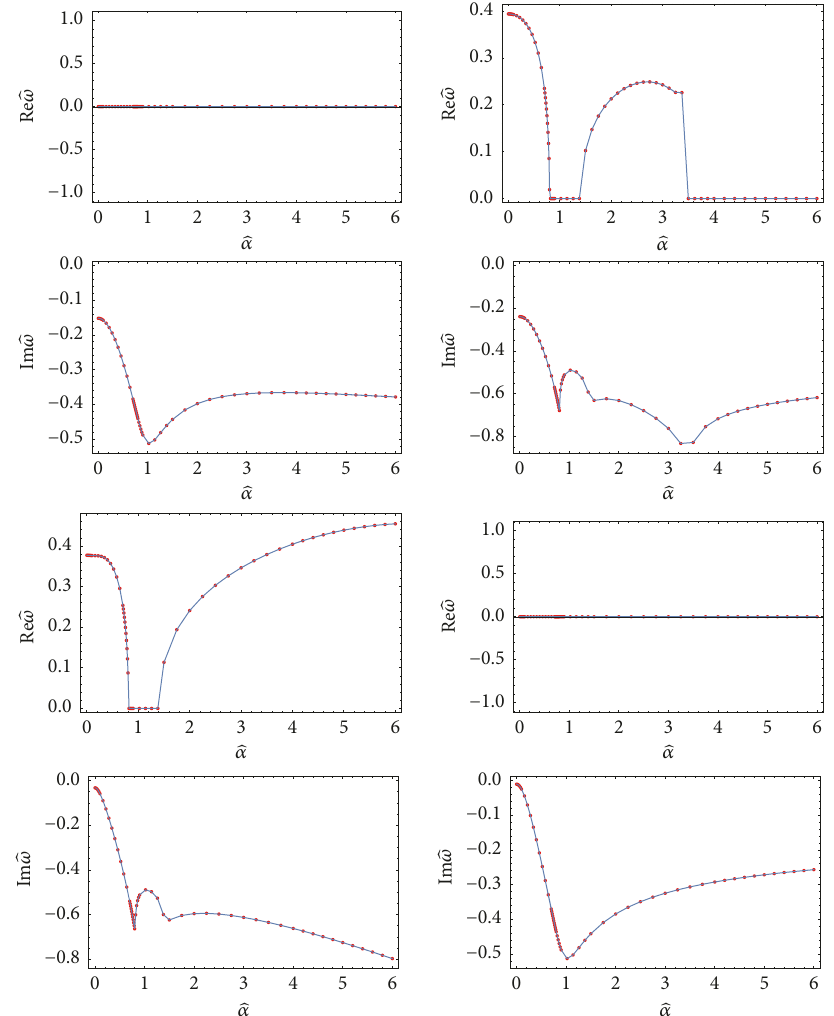
Figure 11: Evolution of the dominant QNMs with ̂𝛼 for |𝛾 1 | = 0.02 (the first two rows are for 𝛾 1 = −0.02 and the last two rows for 𝛾 1 = 0.02 ). The left columns are the QNMs for original theory, and the right ones are that for its dual theory.